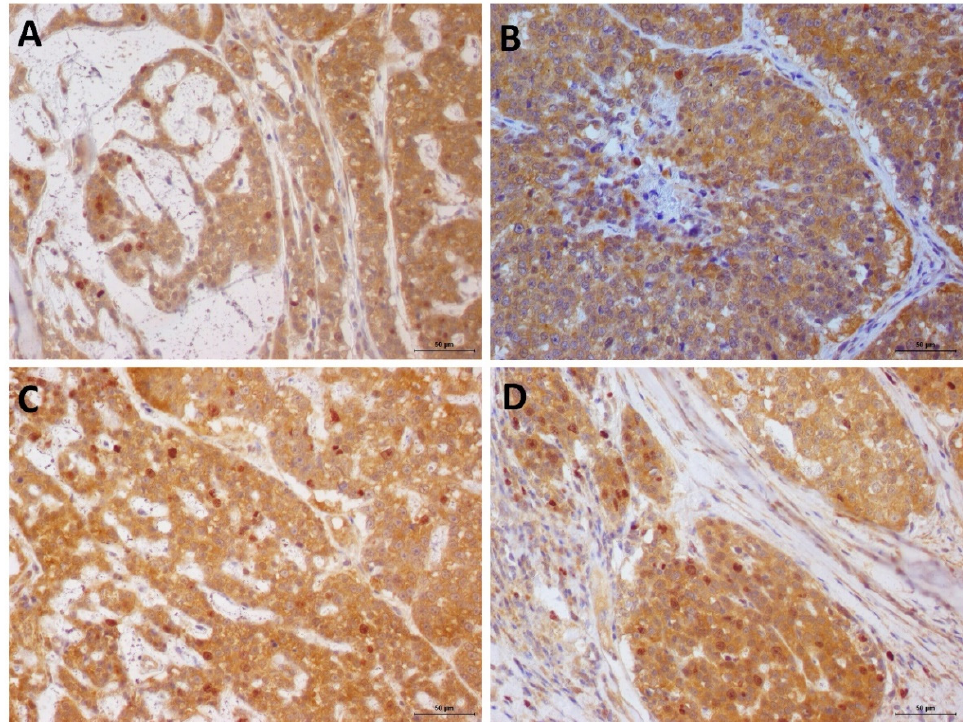
Figure 3. Double immunostaining of COX-2 (cytoplasmic staining—brown) and cleaved caspase-3 (nuclear staining—red) in canine mammary gland tumor samples. ( A , B ): COX-2/caspase-3 double immunostaining at D0. ( C ): COX-2/caspase-3 double staining of the control group tissue samples, on D14. No difference was found when the tissue samples from patients on D0 were compared with those on D14. ( D ): increased number of double-stained cells in a sample on D14, compared with those on D0. Harris hematoxylin counterstain, 3 3 (cid:48) -diaminobenzidine chromogen, and 20 ×